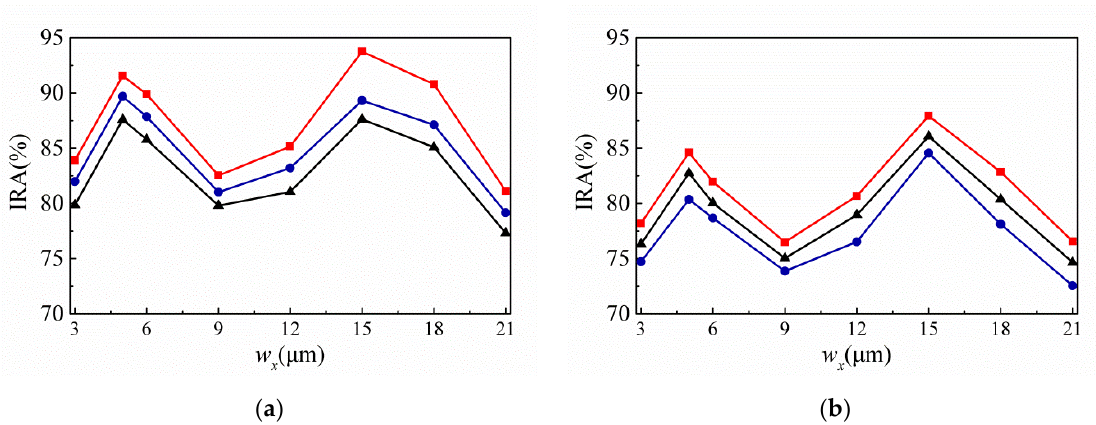
Figure 5. Variances of the IRA with different w y by the function of w x for the thermopiles with SA type ( a ) and MA type ( b ) of SRHA, where the solid lines with triangle, square, and round represent the cases of w y = 4 μm, w y = 5 μm, and w y = 6 μm, respectively.